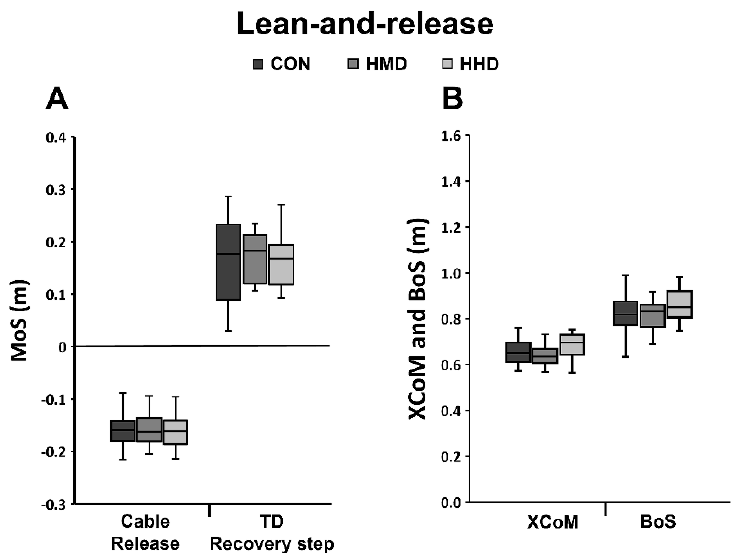
Figure 3. The margin of stability (MoS) and related stability components for the lean-and-release task illustrated with box plots (median, 1st and 3st quartile and whiskers) of all analysed participants for the control condition (CON), head-mounted display (HMD) and hand-held display (HHD). ( A ) MoS at the instants of release and at touchdown of the recovery step (TD); ( B ) extrapolated centre of mass (XCoM) and base of support (BoS) at TD of the recovery step.